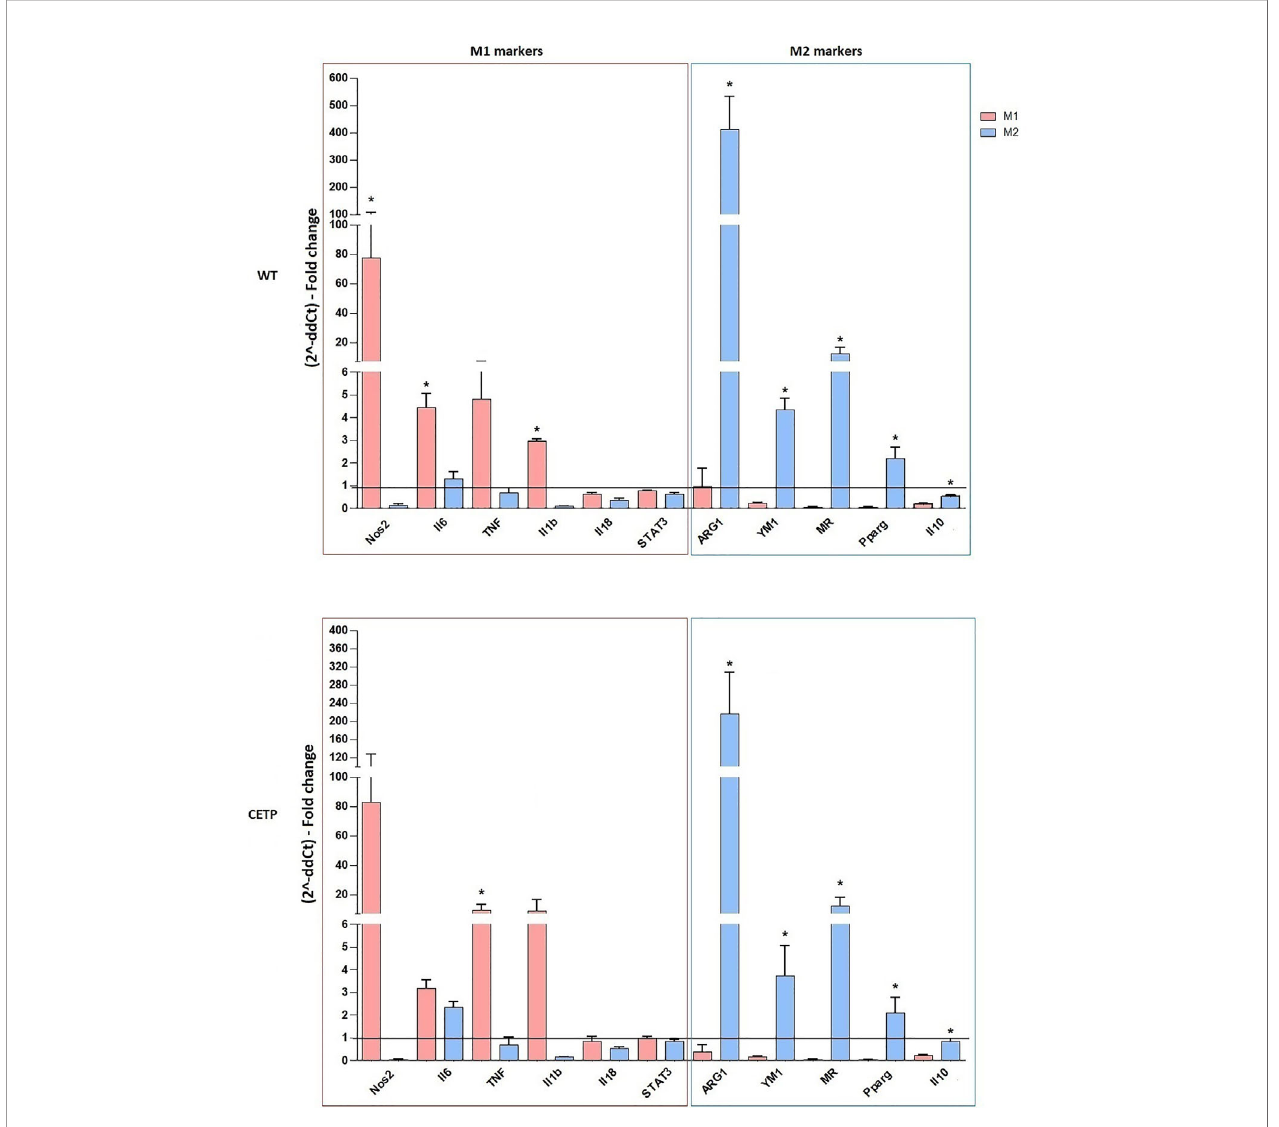
FIGURE 2 | Gene expression of typical M1 and M2 markers from bone marrow-derived macrophages of WT and huCETP Tg mice. In vitro stimulated M1 (5 ng/ml IFN g + 50 ng/ml LPS) and M2 (10 ng/ml IL-13 + IL-4) for 24 h. mRNA expression was determined using RT-PCR. Results are expressed as the mean ± standard deviation and were compared by unpaired Student ’ s t-test (n = 3 – 5). *P <